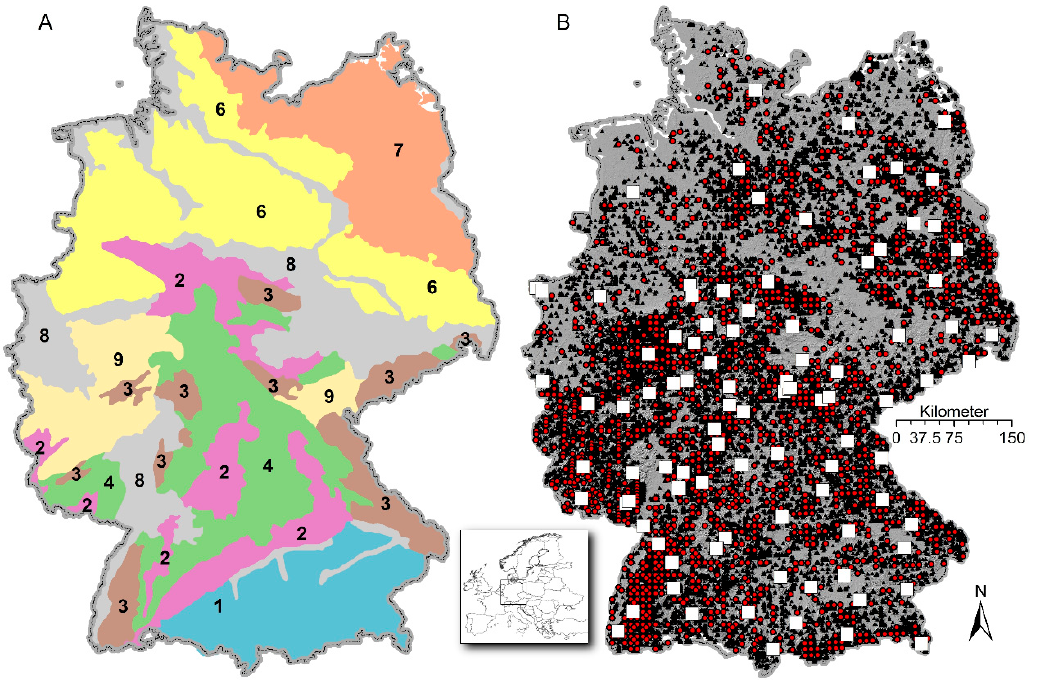
Figure 2. Stratification of Germany in soil landscapes (model regions—( A )) and location of intensive monitoring plots ( □ ), National Forest Soil Inventories (NFSI) plots ( ● ) and National Forest Inventory (NFI) tracts ( ▲ ) in Germany ( B ). Legend of left map: 1—pre-alpine moraines and limestone Alps; 2—hills on limestone bedrocks; 3—hills on crystalline bedrocks; 4—hills on sand, silt, clay bedrocks; 6—old moraines, north German lowland; 7—young moraines, north German lowland; 8—loess regions, fluvial valleys; 9—hills on clay- and silt schist bedrocks. Note: number 5 was deliberately not